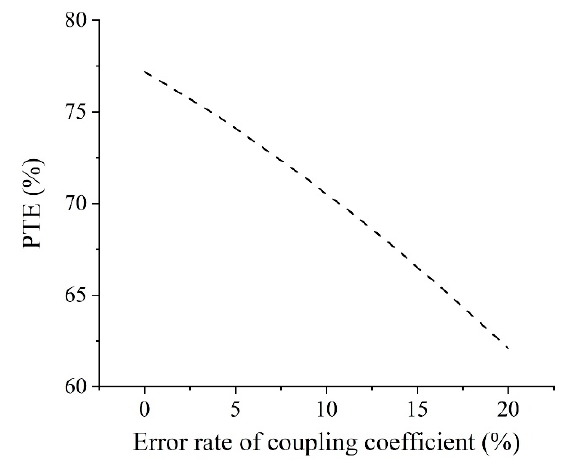
Figure 2. Simulated power transfer efficiency (PTE) with respect to error rate of coupling coefficients between coils in the MISO WPT system.